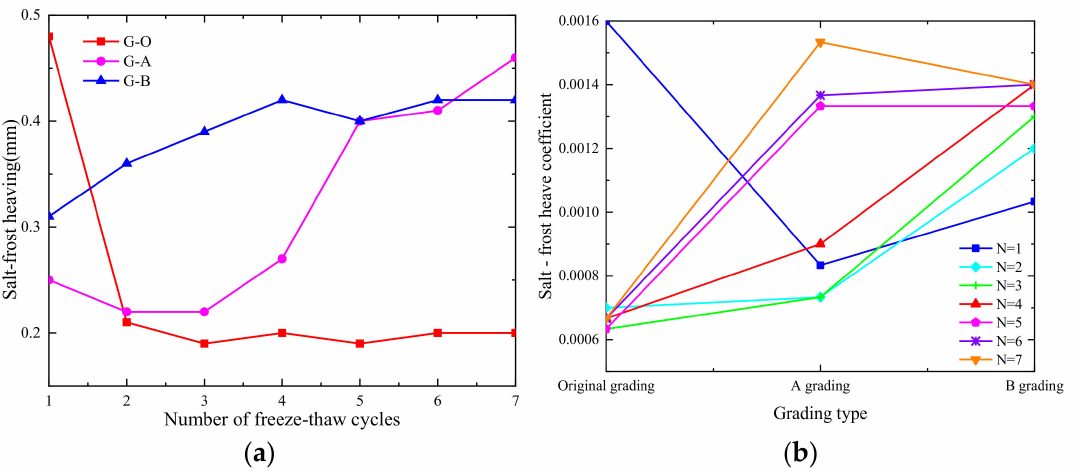
Figure 8. Salt-frost heaving and salt-frost heaving coefficient of saline soil with different gradation: